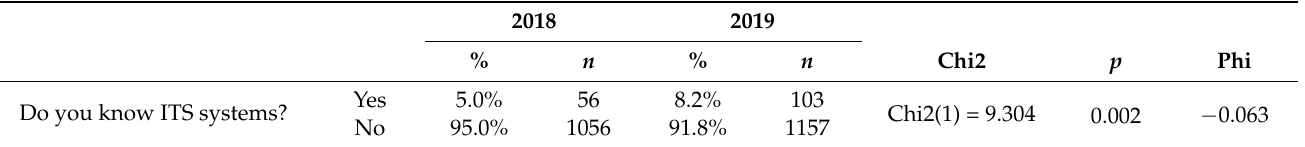
Table 2. Level of knowledge of intelligent transportation systems (ITS)